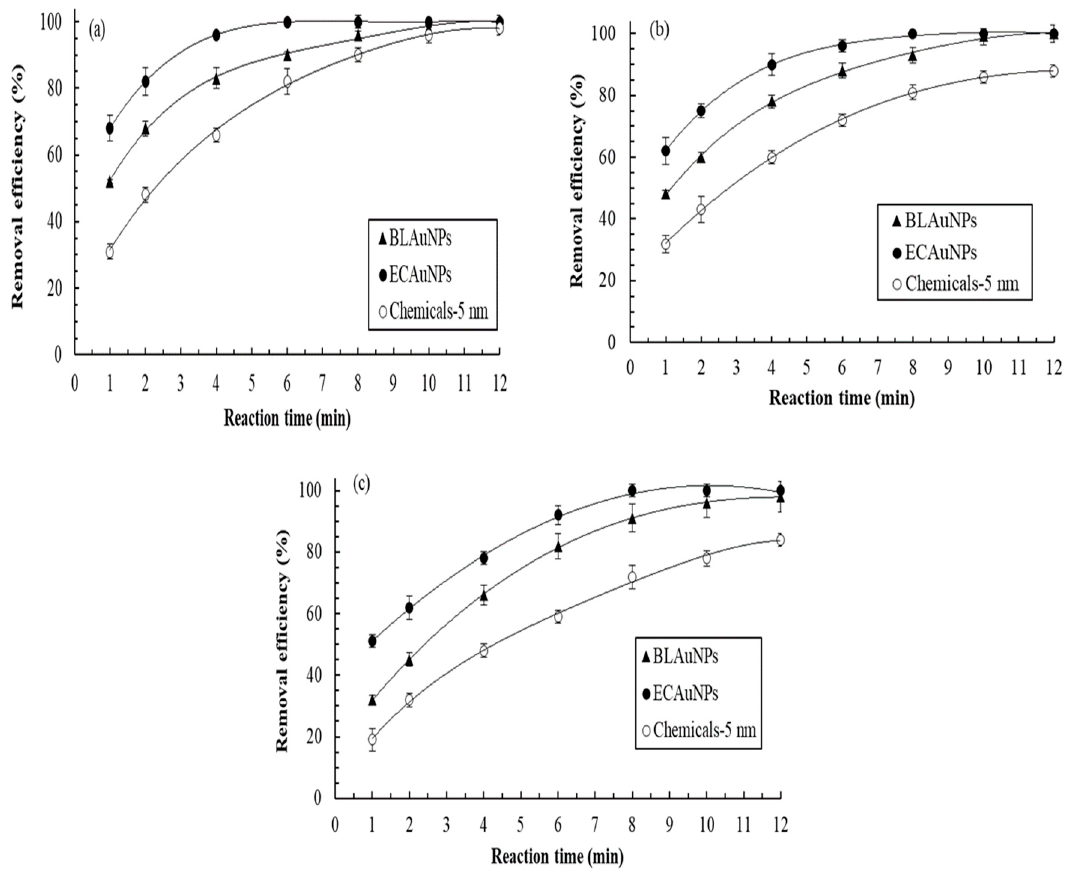
Figure 4. Removal efficiencies of ( a ) VBR ( b ) MG and ( c ) MB by BLAuNPs, ECAuNPs, and Chemicals-5 nm during the 12 min treatment periods (dye concentration: 100 mg/L; AuNPs concentration: 25 mg/L).